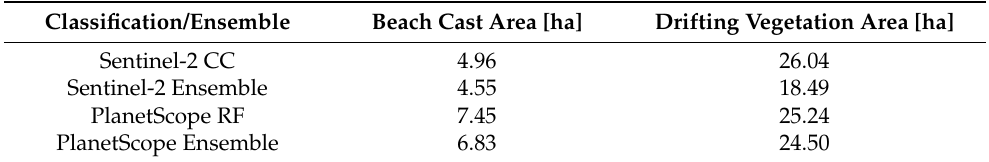
Figure 7. Results of the best classification ensemble run (RF, CC, SVM, NB, SGB) for PS. Table 4. Mapped area of beach cast and drifting vegetation with the four best classifica- tion/ensemble